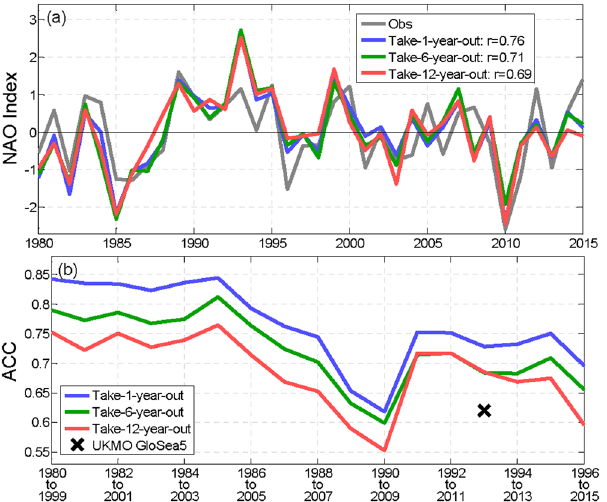
Figure 1. ( a ) The observed and predicted DJF-mean NAO index for the 1980–2015 period. ( b ) The forecast skill of each 20-year window. NAO is defined as the difference between the monthly mean sea level pressure (SLP) anomalies averaged over the domains of (50°W–10°E, 25–55°N) and (40°W–20°E, 55–85°N). Similar results are obtained with several other popular NAO indices (see Methods). The year corresponds to the January of each DJF